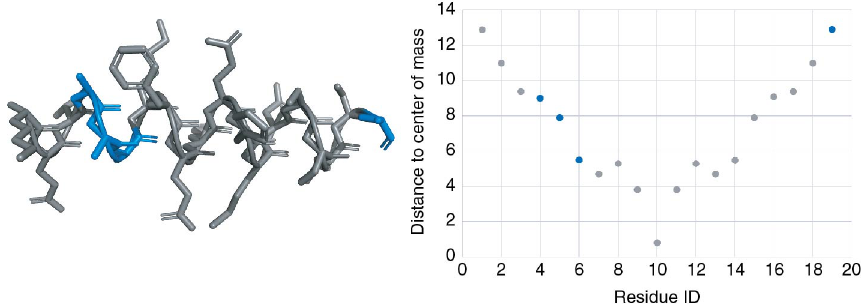
Figure 5: 3D structure visualization and analytical plot of residue distance to the center of mass for the KETAAAKFER- QHMDSSTSA peptide in two different spaces of the same